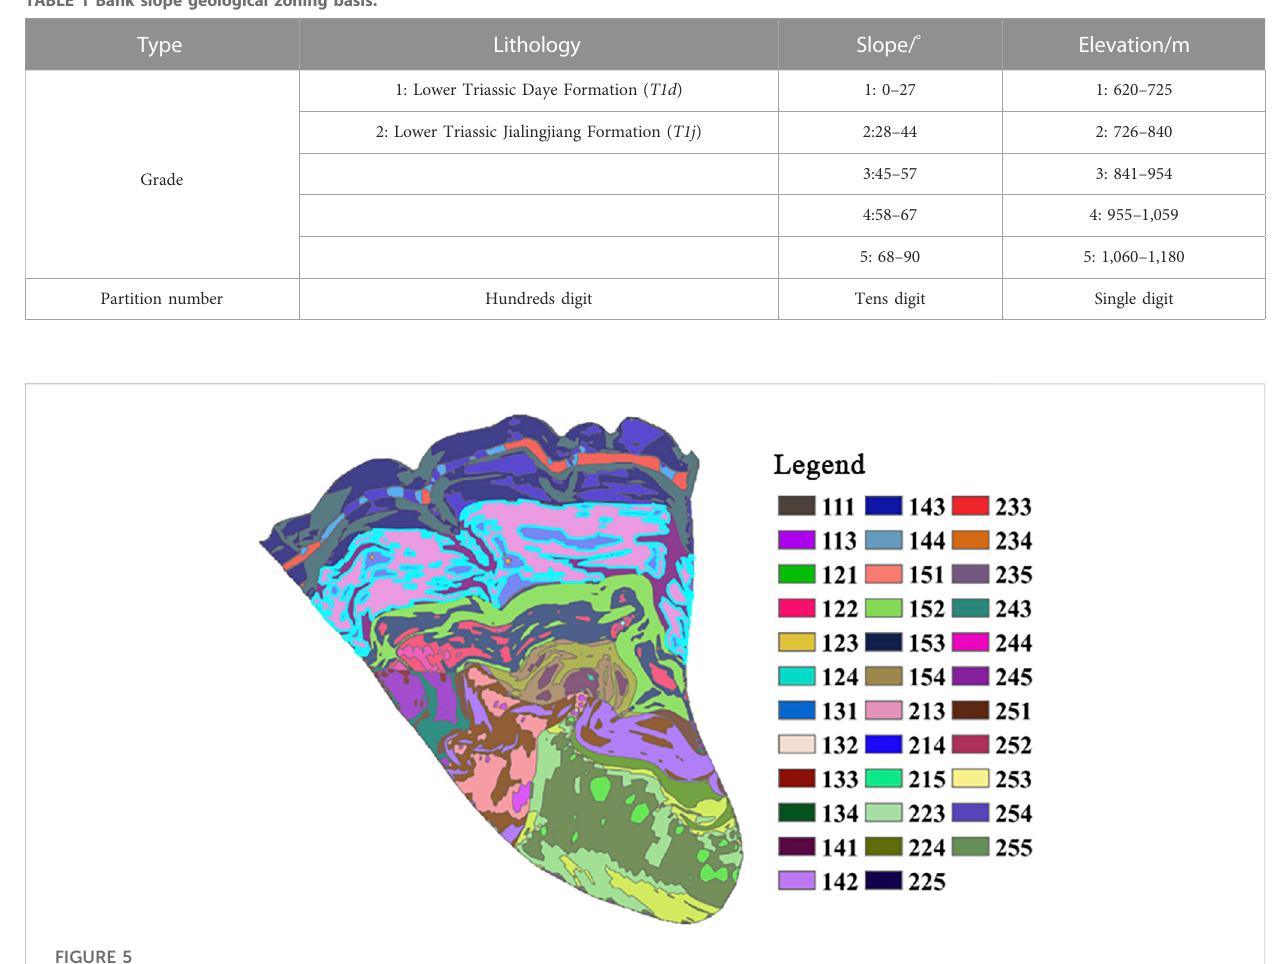
FIGURE 5 Geologic geometric displacement superimposed partition map.